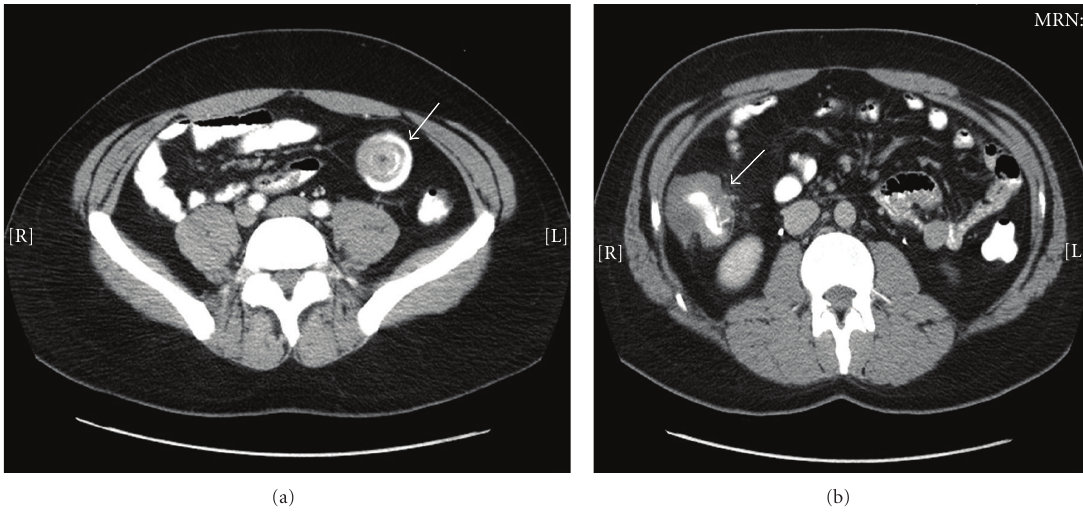
Figure 1: CT scan revealed intussusception of the small bowel (a) and thickening of the right colon (b).